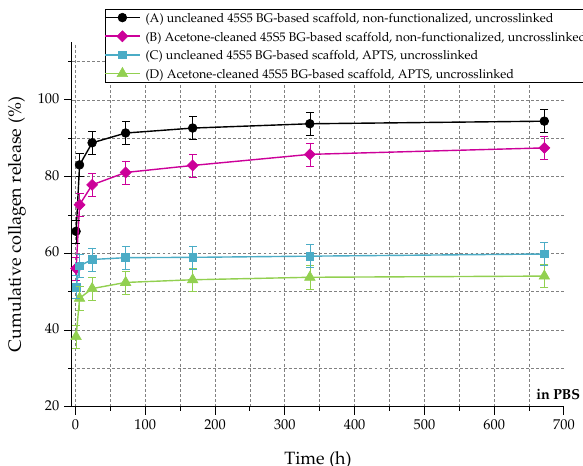
Figure 10. Cumulative collagen release from different types of 45S5 BG-based scaffolds in PBS.